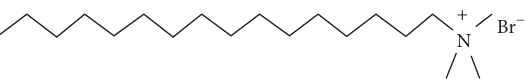
F 1: Structure of the surfactant cetyltrimethylammonium